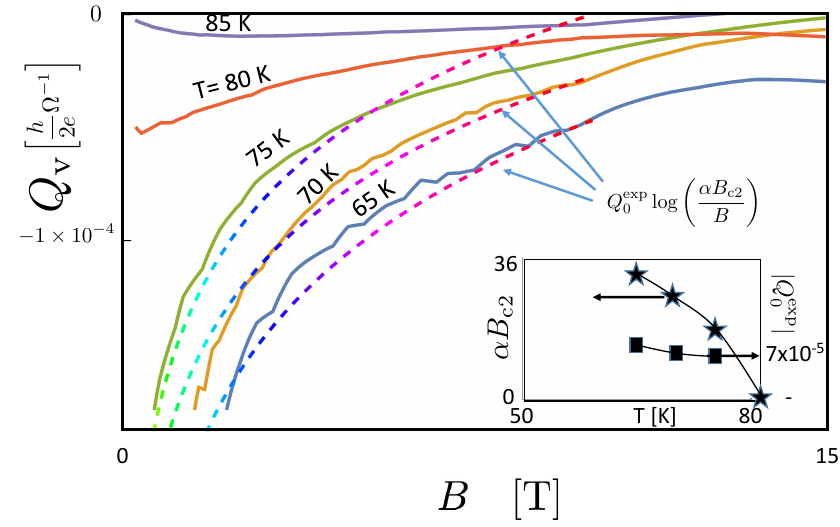
Figure 7: Moving vortex charge Q extracted from Zhao et al. [ 6 ] . The resistivity v data of two unit cell thickness film of Bi Sr CaCu O are inputs into the procedure 2 2 2 8 − x described in Section 7. Dashed lines are fits to theory, Eq. 32. Inset: Fitted pa- ( T ) , (which is negative). The weak temperature dependence rameters α B and Q exp c2 0 of Q exp